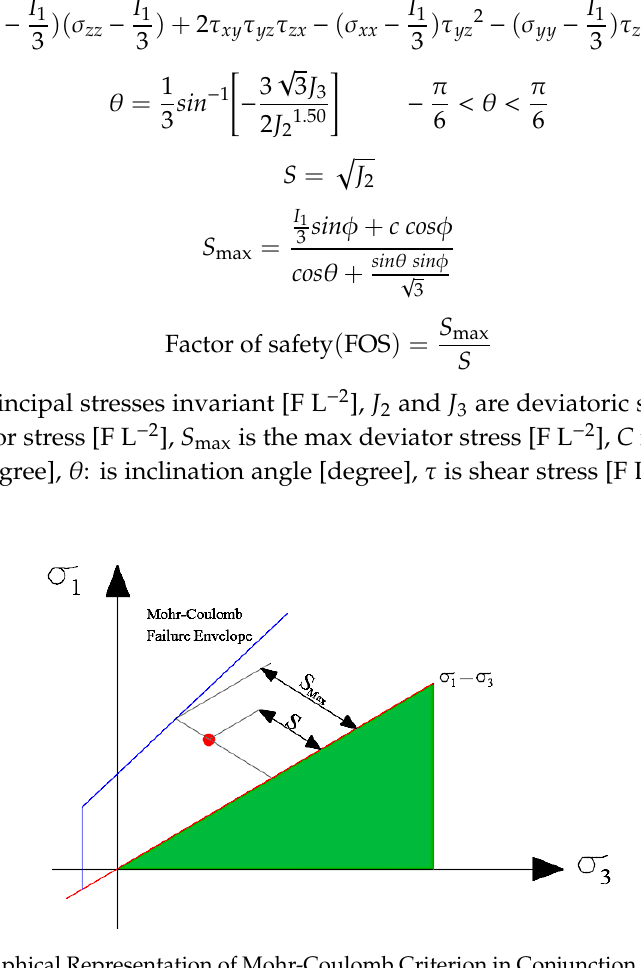
Figure 3. 2-D Graphical Representation of Mohr-Coulomb Criterion in Conjunction with shear strength reduction method (SSRM) Technique (Phase 2 V.8, 2011) [34].